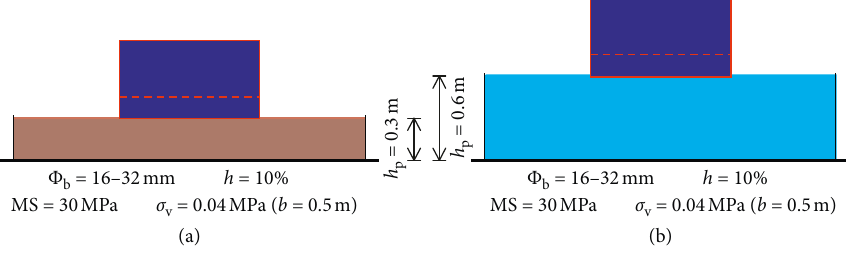
Figure 2: Analysed thickness of the aseismic layer. (a) h